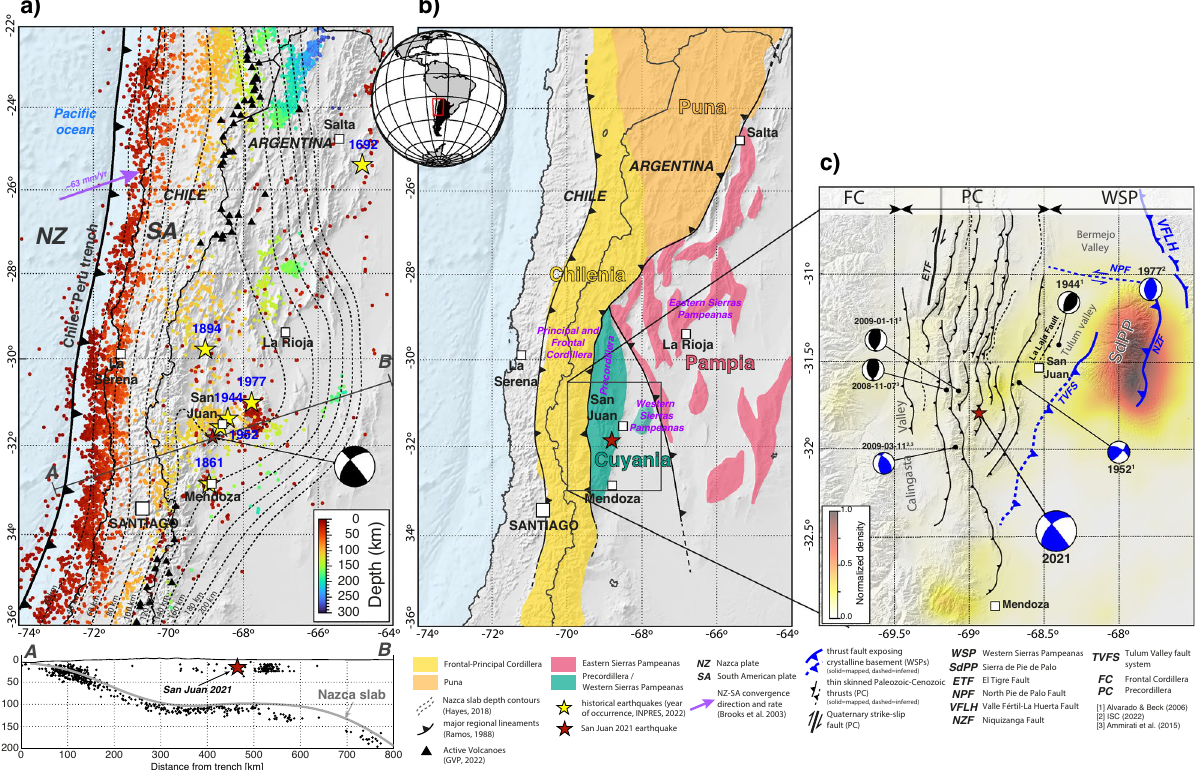
Figure 1. General seismotectonic context of the western margin of South America. ( a ) Map showing the distribution of seismicity from the 1964–2018 EHB-Catalog 13 . Dashed lines illustrate contours to top of the Nazca oceanic slab after the SLAB 2.0 model 16 . Black triangles show Holocene active volcanoes. Yellow stars indicate epicenters of major historical retroarc earthquakes 14 . The red star shows the location of the 2021 San Juan earthquake and corresponding focal mechanism 15 . The purple arrow shows the Nazca-South America convergence velocity rate (fixed South America reference frame). The lower cross section shows seismicity projected onto section line A–B; gray line in the cross section corresponds to the top of the Nazca oceanic plate following 16 . ( b ) Map highlighting the main structural features and retroarc domains of the southern central Andes 17 . ( c ) Regional map of the study area showing main retroarc structures and associated crustal seismicity above the Chilean-Argentinian flat-slab subduction segment 13,18 . Focal mechanism solutions are shown for regionally significant earthquakes at middle-crustal (blue) or upper-crustal (black) focal depths. This map was created using the GMT package (V.6.0.0, https:// www. gener ic- mappi ng- tools. org/). Topographic information corresponds to the Shuttle Radar Topographic Mission 90m database (https:// srtm. csi. cgiar. org/ srtmd ata/) and the ETOPO1 Global Relief Model (https:// www. ngdc. noaa. gov/ mgg/